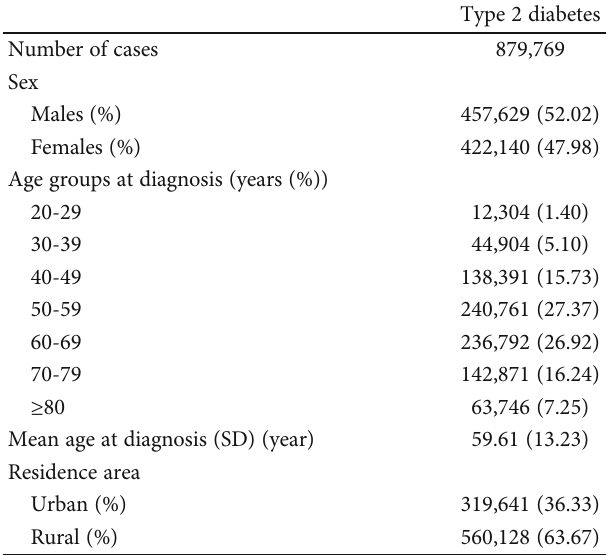
Table 1: Baseline characteristics of type 2 diabetes cases included in study,